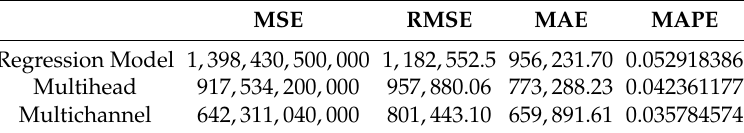
Figure 13. Actual vs. all predicted models with the 1990 dataset. Table 6. Overall model results with the 1990